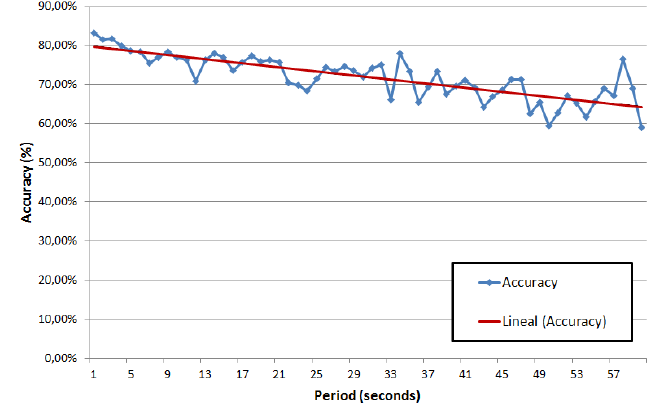
Figure 10. Map-matching accuracy over